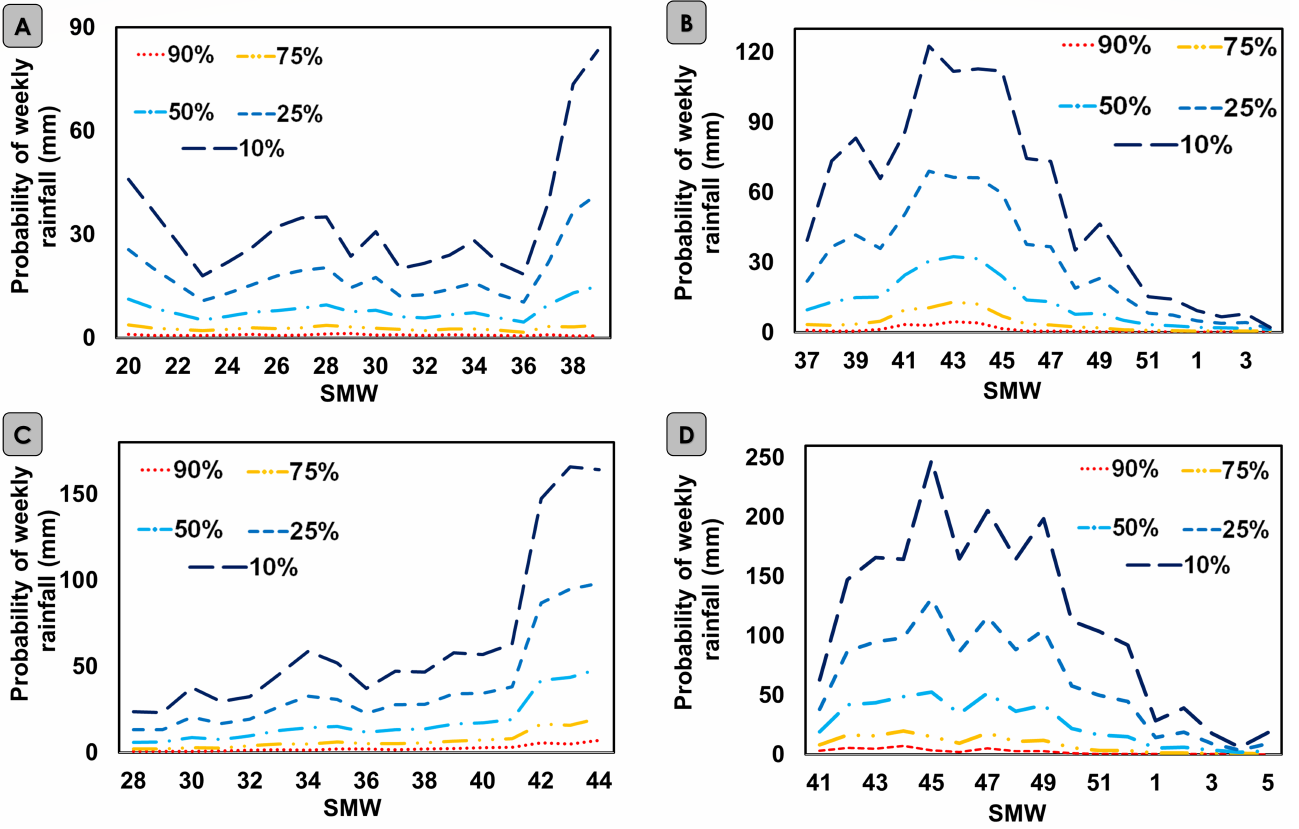
Figure 6. Weekly assured rainfall at different probability levels. ( A ) Kar season (Sadivayal), ( B ) Thal- adi season (Sadivayal), ( C ) Kuruvai season (Karaikal), and ( D ) Late Thaladi season (Karaikal). Excessive weekly rainfall (more than 50 mm) with a probability level of 25 percent occurs in the 41st and 42nd SMW during the Thaladi and Late Thaladi seasons. Incomplete gamma probability analysis of annual rainfall indicates that water requirement supported by rain for the irrigated Kuruvai and Late Thaladi rice (between 700 to 1100 mm) is available at more than 50 percent probability. Nevertheless, the same amount of water is available at less than 25 percent probability for the Kar and Thaladi rice-growing seasons in the Sadivayal